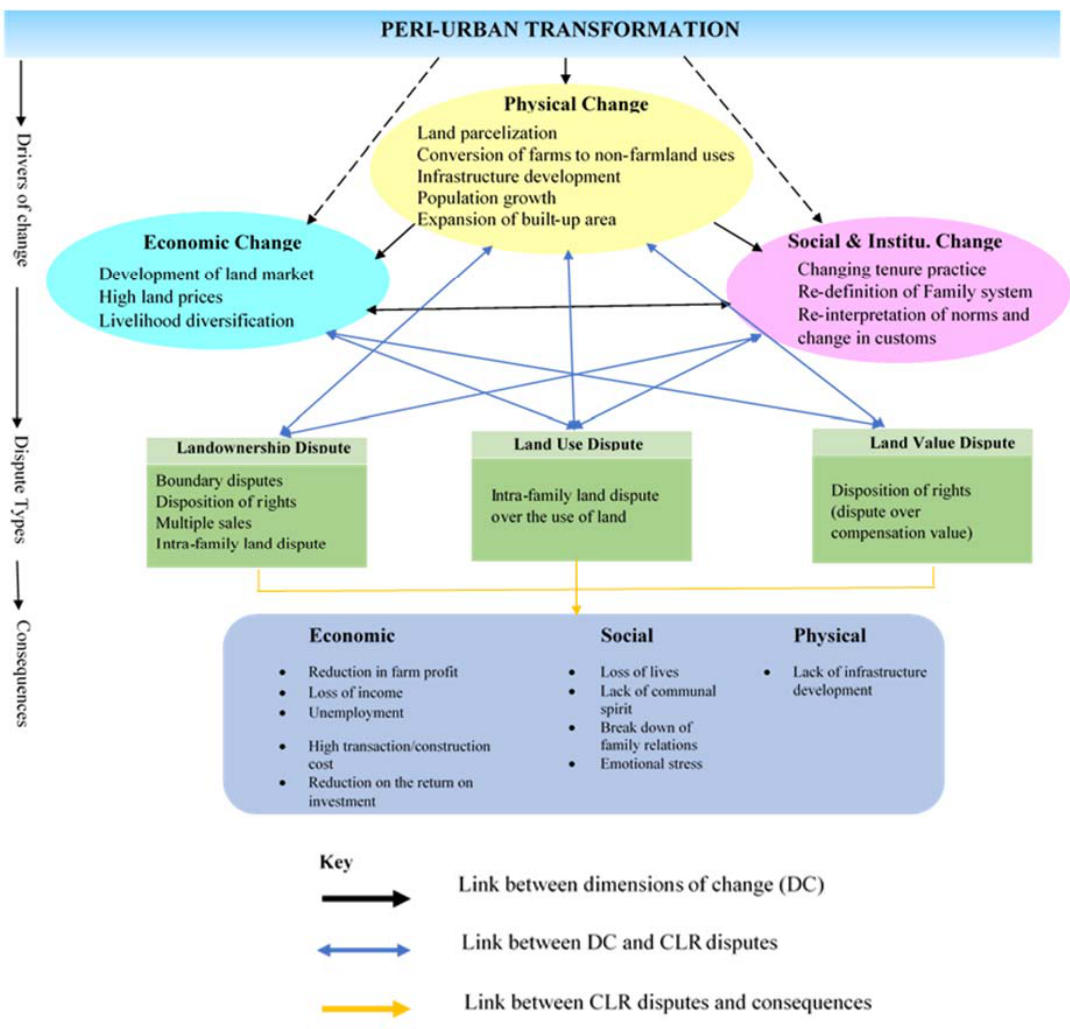
Figure 6. Linkages between peri ‐ urban transformation, customary land rights (CLRs) disputes and their effects on peri ‐ urban development (source: Authors).